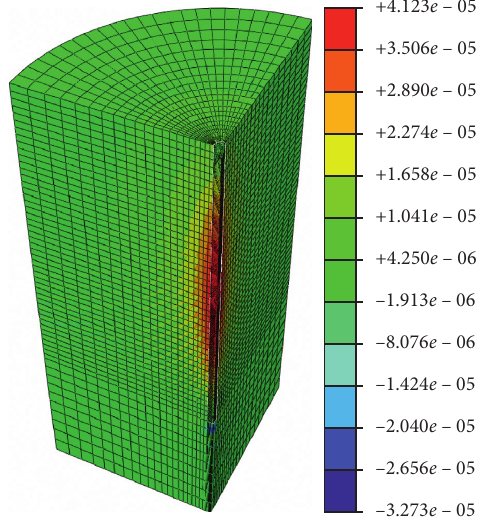
Figure 23: Vertical deformation contours of pile-soil interaction.